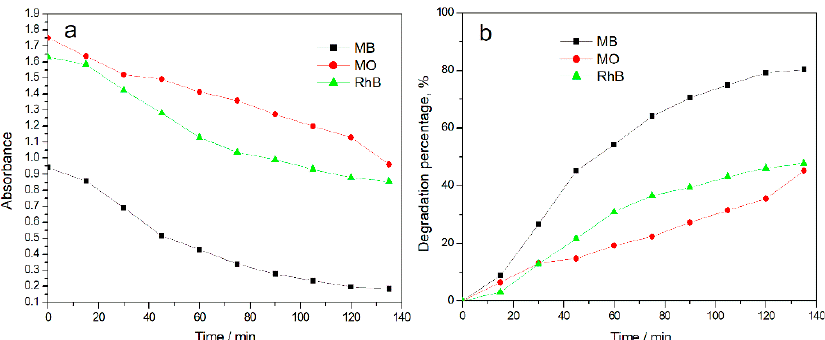
Figure 4. Absorbance curves of CPTPPCu/PMMA electrospun fiber for catalytic degradation of different organic dye solutions ( a ). Degradation percentage curves of different organic dyes catalyzed by CPTPPCu/PMMA electrospun fibers ( b ).